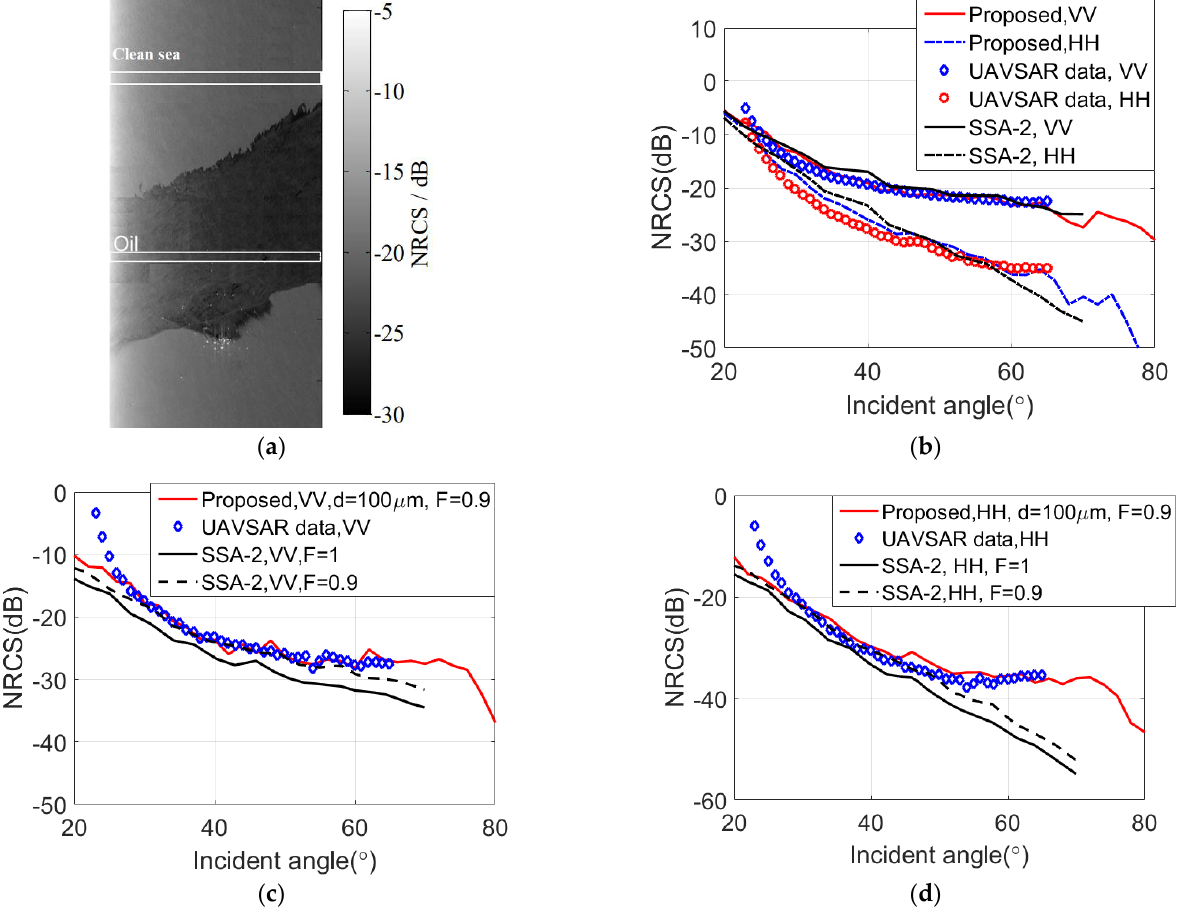
Figure 6. ( a ) The UAVSAR measured data, the comparison of the simulated NRCS, the SSA-2 results simulated by Zheng et al. [26], and the measured result; ( b ) Clean sea, VV, and HH; ( c ) Oil spill-covered sea and VV; ( d ) oil spill-covered sea and HH. Table 2. The information of the measured data (see Refs. [42,43]).